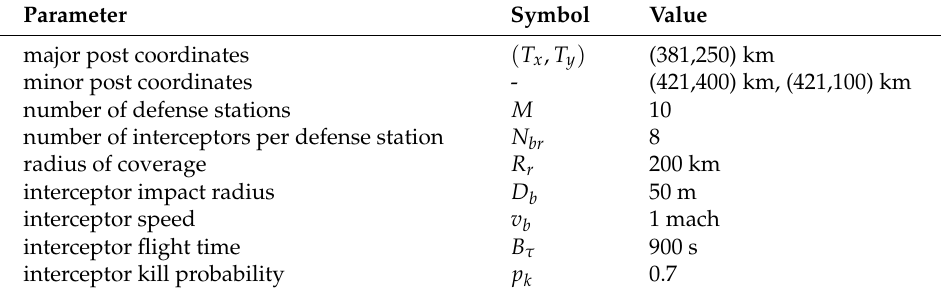
Table 1. Parameters of defense force.